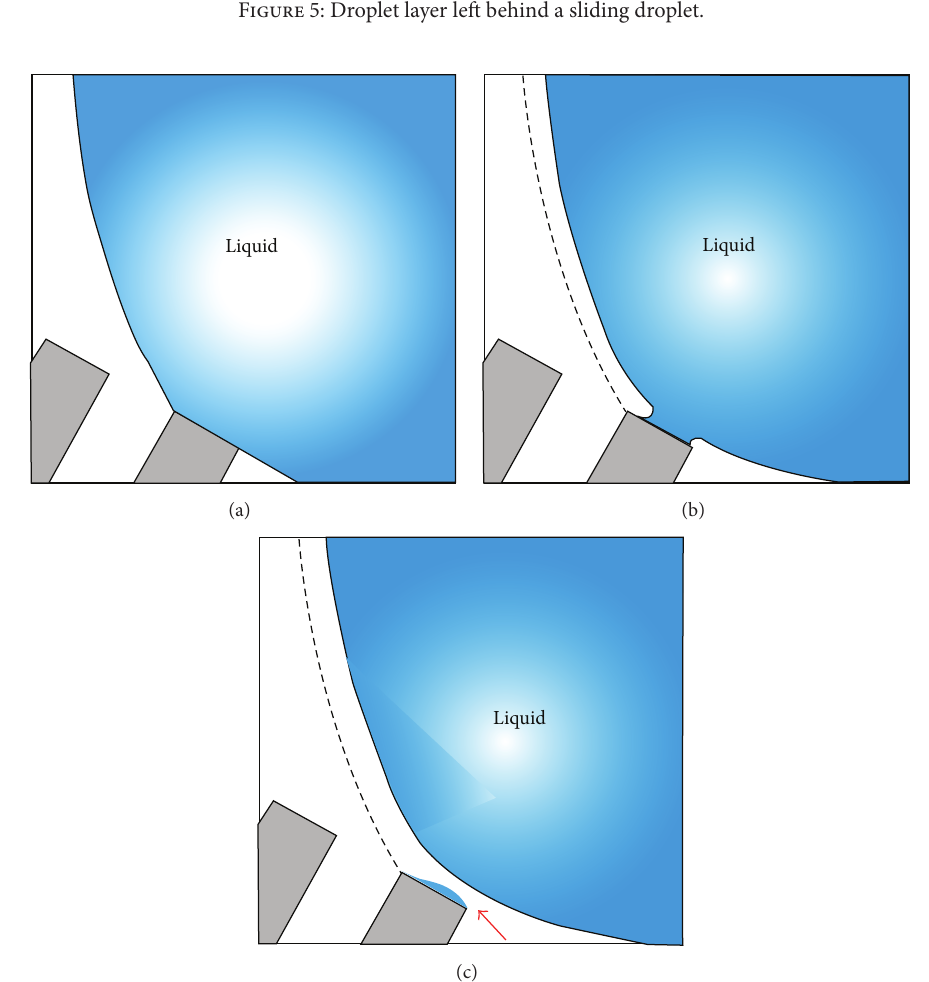
Figure 6: Detaching process of a droplet on micropillared